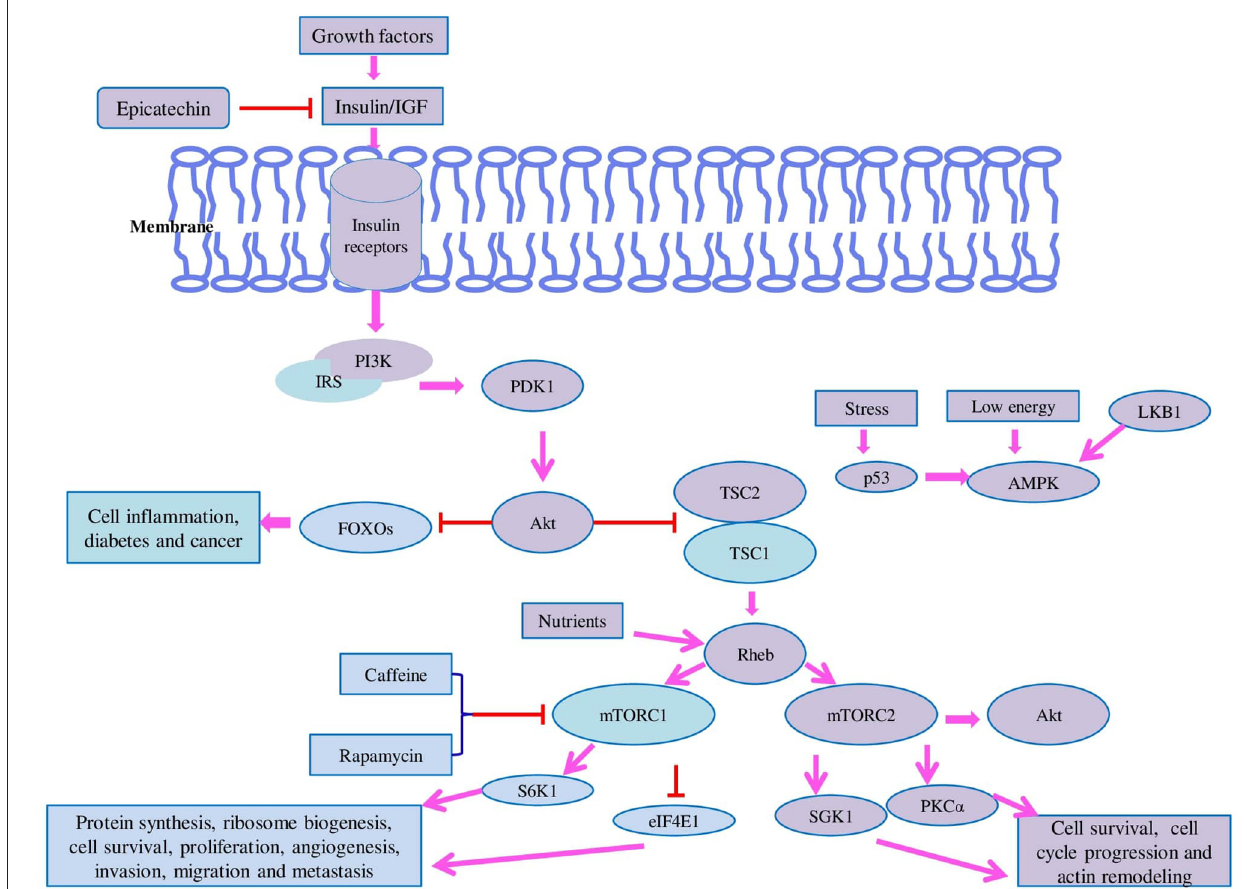
FIGURE 5 | Model of the mammalian target of rapamycin (mTOR) pathway: the mTOR pathway has two major components called TOR complex 1 (TORC1) and TOR complex 2 (mTORC2) which regulate different cellular functions. mTORC1 is sensitive to rapamycin and play role in protein synthesis, ribosome biogenesis, cell survival, proliferation, angiogenesis, invasion, migration, and metastasis whereas mTORC2 is insensitive to rapamycin and regulates cell survival, cell cycle, and actin remodeling. In response to growth nutrients, the mTOR pathway is regulated by the PI3K cascade. mTOR is negatively regulated by tuberous sclerosis proteins called TSC1 and TSC2 which exist as heterodimers. In response to insulin signaling, Akt phosphorylates TSC2 which makes it functionally inactive. Shortage of nutrients mainly amino acid starvation leads to dephosphorylation of well-known substrates of mTORC1 such as ribosomal S6 kinase (S6K) and eukaryotic translation initiation factor 4E-binding protein (4E-BP) whereas in the supply of nutrients, restoration of amino acids enables phosphorylation of S6K and 4E-BP which accelerates protein synthesis. Amino acids activate mTORC1 in two ways either via inhibition of TSC1-TSC2 or by stimulation of Rheb. AMPK is activated under low energy (high AMP/ATP ratio) and promotes fatty acid oxidation and inhibits protein synthesis. The tumor suppressor LKB1 is responsible for the activation of AMPK which leads to inhibition of mTORC1-mediated phosphorylation of S6K1 and 4E-BP1. AMPK also directly activates TSC2 via its phosphorylation and increases its activity which ultimately leads to repression of mTORC1 signaling. High-energy situation mediates upregulation of mTORC1 activity. Upon stress conditions, p53 is activated and inhibits the mTOR activity by the AMPK-TSC2 mechanism. In contrast to mTORC1, mTORC2 is insensitive to nutrients but responds to growth factors such as insulin which requires PI3K. For the activation of mTORC2, ribosomes are very crucial. mTORC2 binds to ribosomes in an aPI3K-dependent manner and regulates protein kinase B (Akt), glucocorticoid-induced protein kinase 1 (SGK1), and protein kinase C- α (PKC- α ). SGK-1 is also activated by mTORC2 and controls the growth and